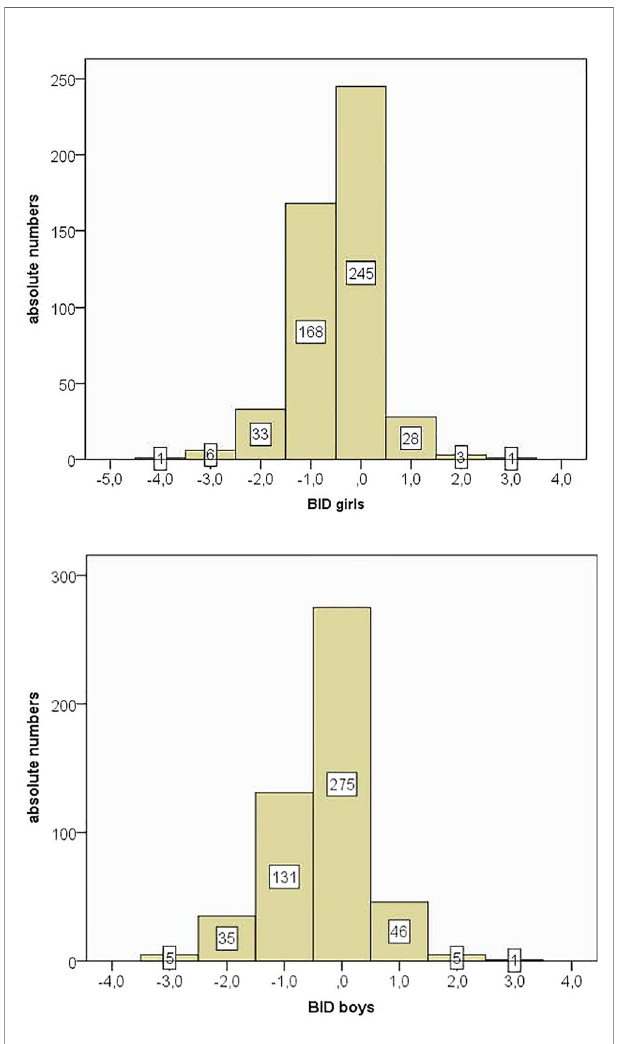
FIGURE 2 | Body image dissatisfaction scores — distribution in boys and